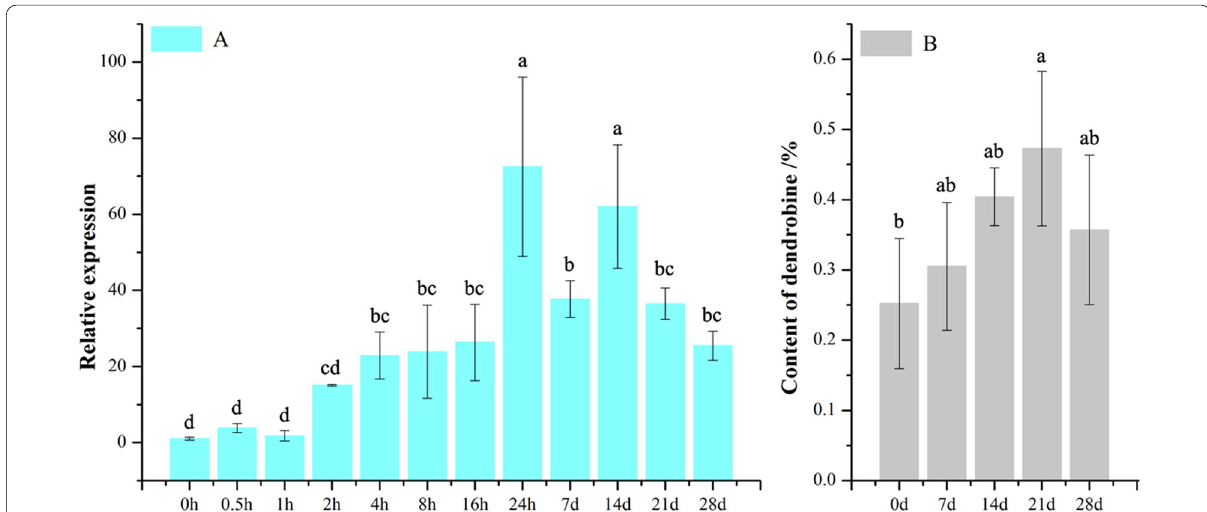
Fig. 1 The relative expression of DnFPPS at different time points (cyan column) and the content of dendrobine (gray column) in D.nobile after MeJA